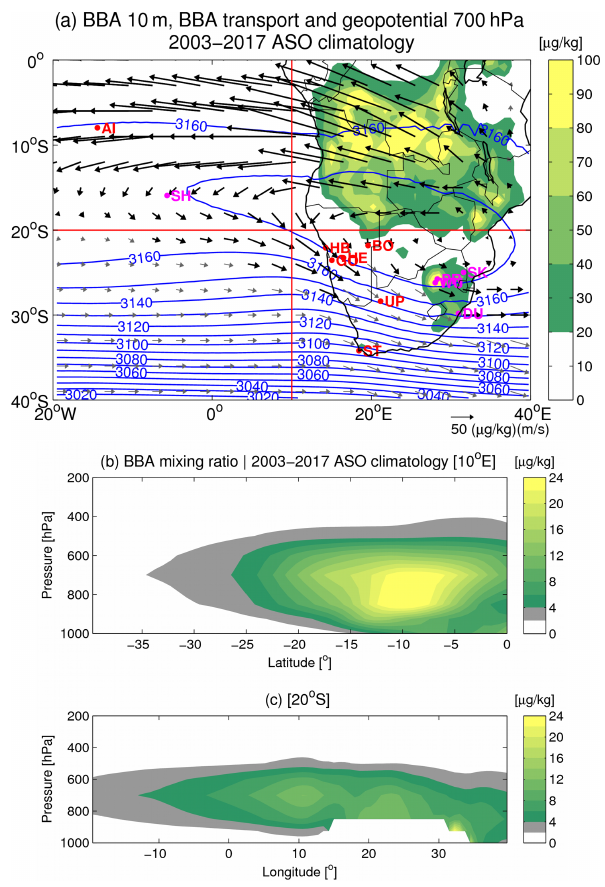
Figure 2. The 2003–2017 ASO climatology derived from CAMS reanalysis: (a) organic matter mixing ratio at 10m (µgkg − 1 , shad- ing), organic matter transport at 700hPa (µgkg − 1 ms − 1 , arrows) and geopotential height at 700hPa (m, contours); vertical cross- sections of the organic matter mixing ratio (µgkg − 1 ) at (b) 0 ◦ E and (c) 25 ◦ S. In (a) , thick arrows highlight organic matter transport cor- responding to an organic matter mixing ratio greater than 4µgkg − 1 ; red lines indicate where organic matter mixing ratio cross-sections are computed; red dots indicate the locations of the AERONET sta- tions used in this study (see Table 1 for details); and magenta dots indicate the locations of available stations not used in this study (see Sect. 2.2 for